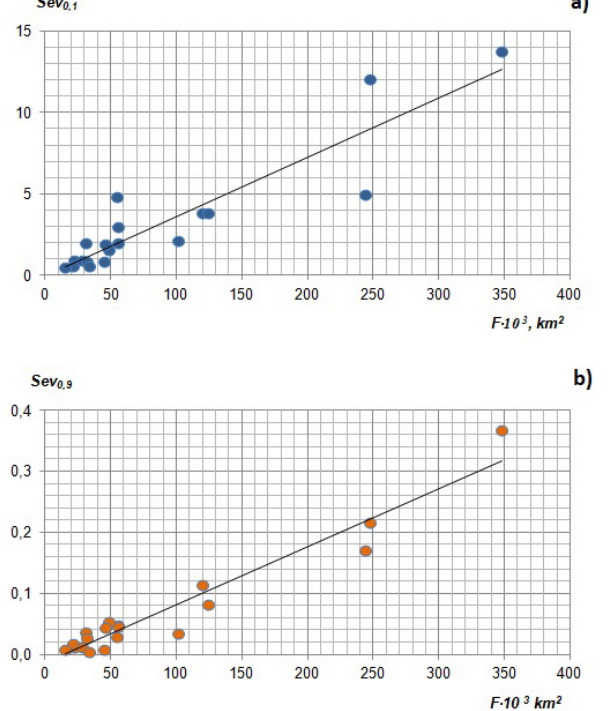
Figure 5. Dependency between the “severity” and catchment area for 0.1 (a) and 0.9 (b)